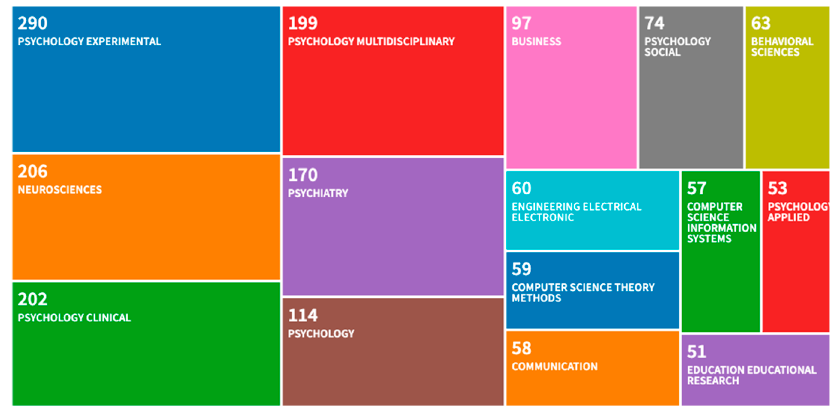
Figure 6. Top 15 disciplines of publications containing the term “vividness” in the title, abstract or keyword fields.